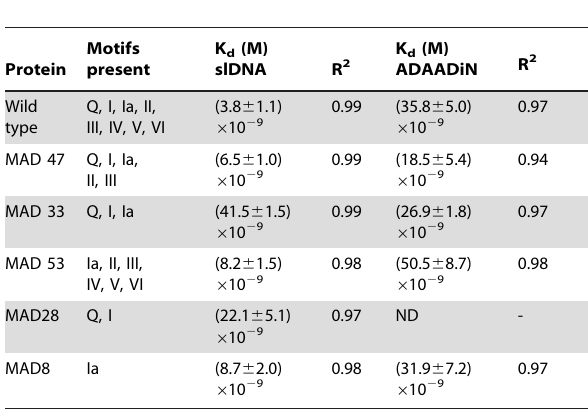
Table 2. Delineating the motifs required for the interaction of ADAADiN with